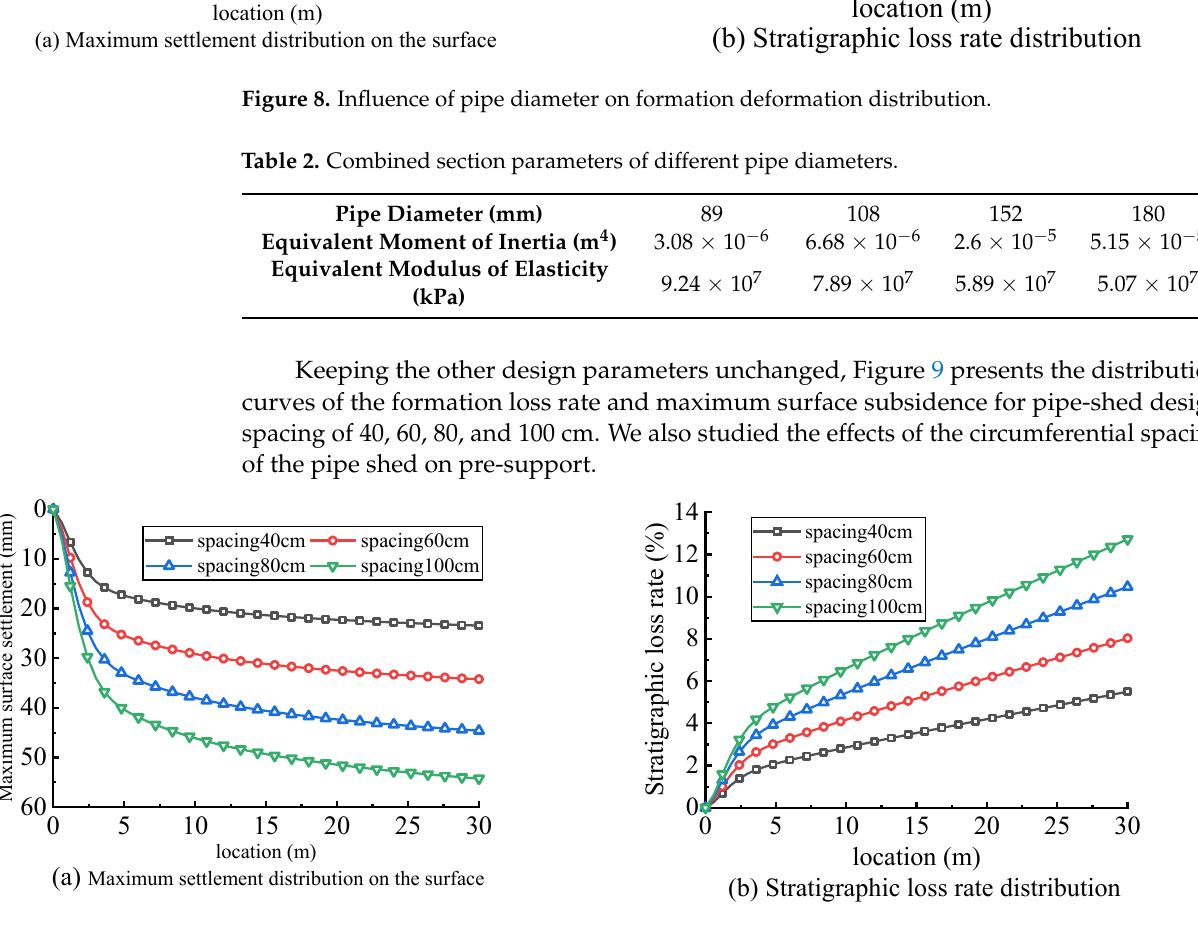
Figure 9. Influence of circumferential spacing on formation deformation distribution.